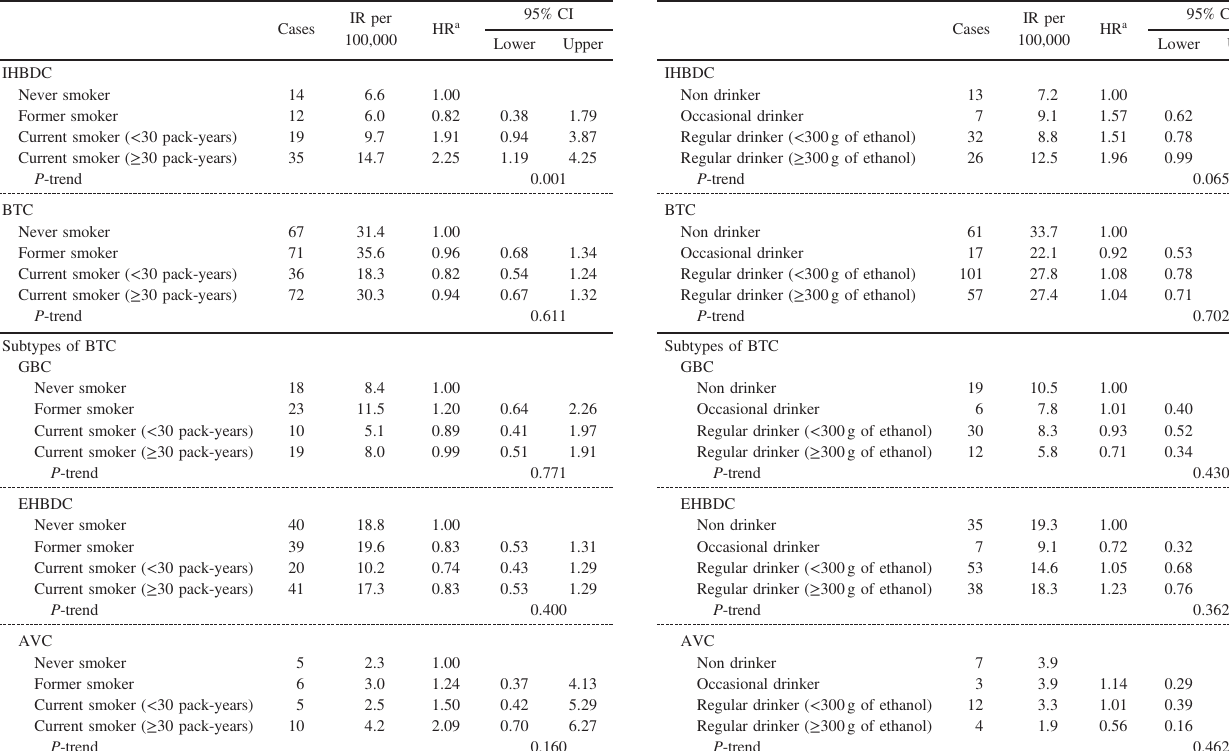
BTC Never smoker